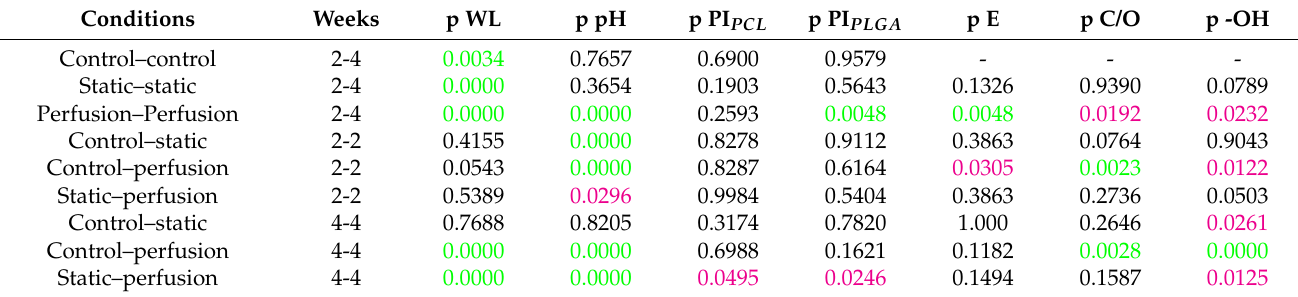
Table 1. p -values of statistical analysis run in this work: % of weight loss (WL), pH variation, polydispersity index (PI) from PCL and PLGA, elastic modulus from compression test, C/O ratio and % of O-C=O bonds. p < 0.05 in pink, p < 0.01 in green. ANOVA test was used to assess significant differences between timepoints and the pair-wise multiple comparison procedure was performed using the Turkey’s HSD